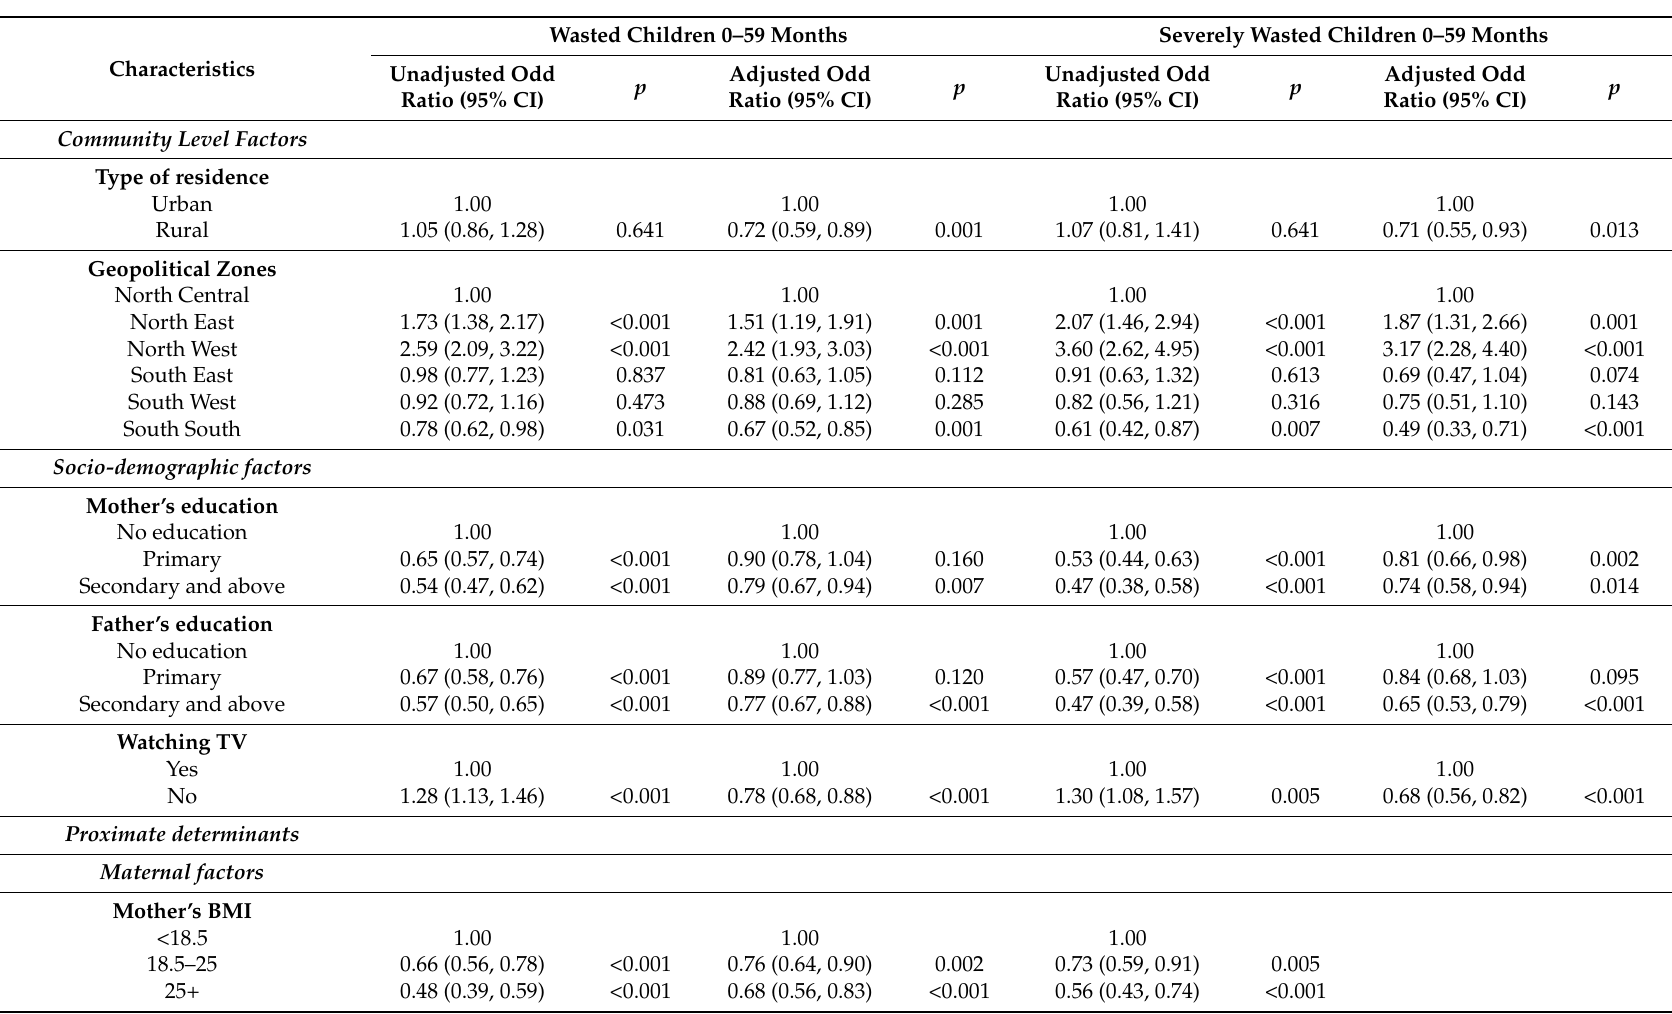
Table 2. Unadjusted and adjusted odds ratios (OR) (95% CI) for wasted and severely wasted children aged 0–59 months.